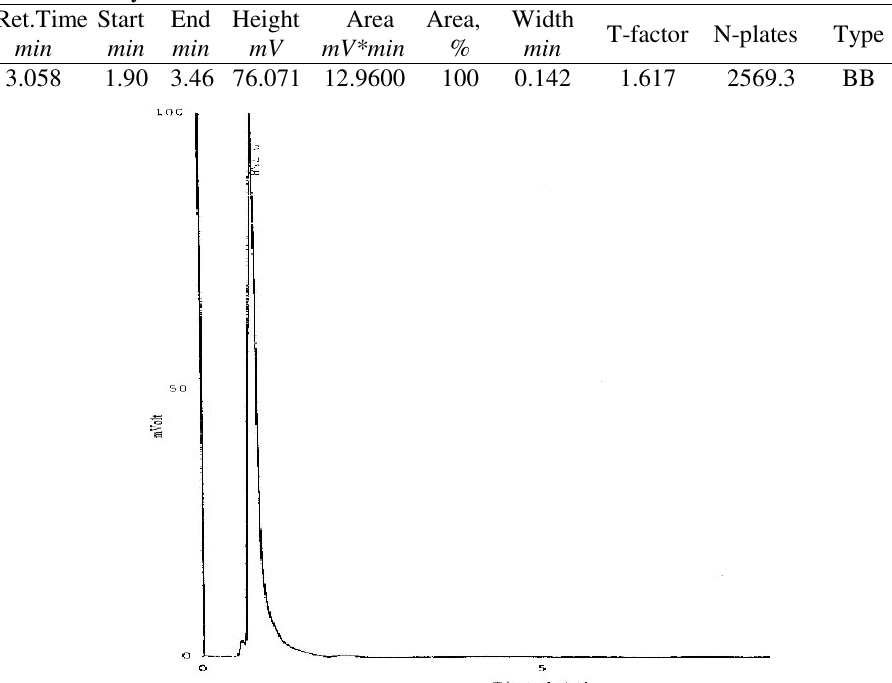
Figure 4. HPLC Chromatogram and data peak report of cloxacillin 250 mg capsules manufactured by Farabi Pharmaceutical Co. of